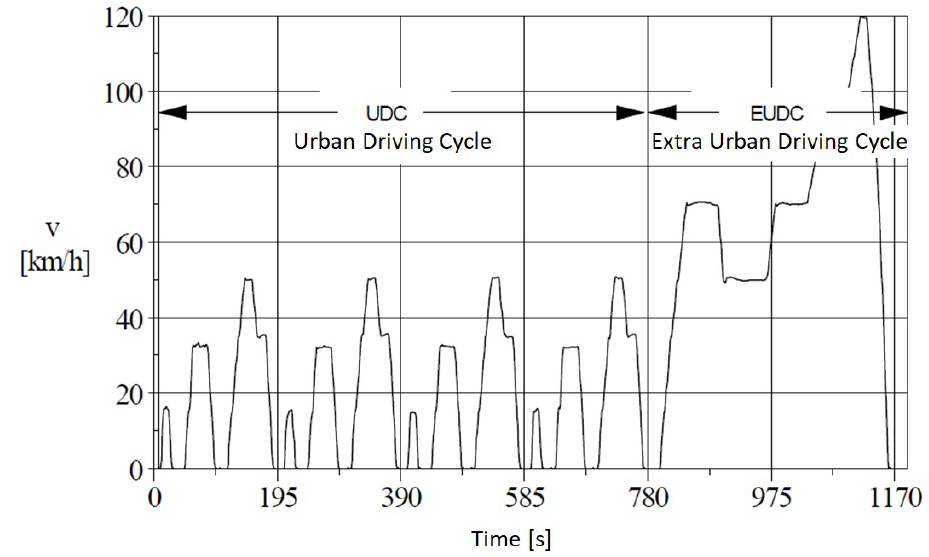
Figure 2. Chart showing vehicle speed during test conducted according to ECE regulations, covering an urban driving cycle (UDC) and extra-urban driving cycle (EUDC) ( v : velocity)